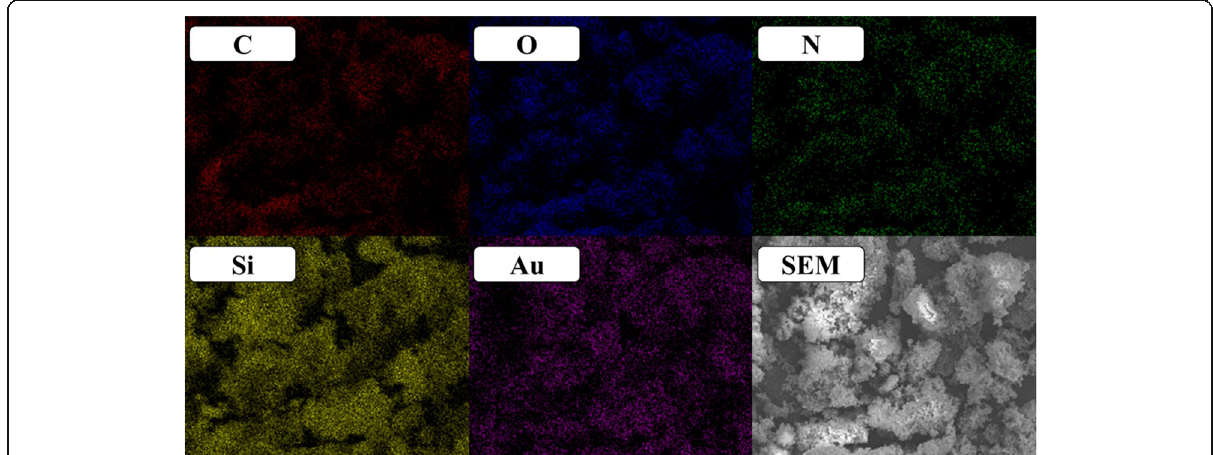
Fig. 5 SEM-EDX mapping results of cellulose-amino POSS hybrid composite by sol-gel